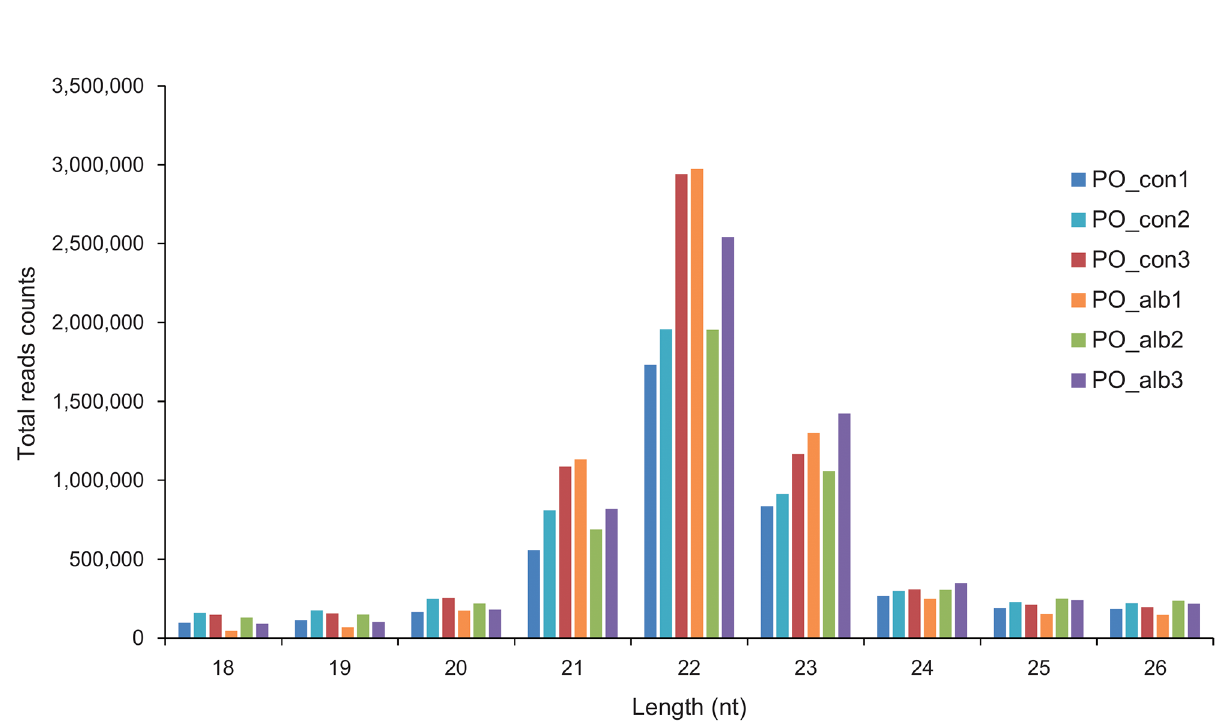
Fig 4. Length distribution of small RNAs. The clean reads of small RNAs were distributedfrom 18 nt to 26 nt in six librariesincluding PO_con1, PO_con2, PO_con3, PO_alb1, PO_alb2, and PO_alb3. The reads of 20–24 nt accountedfor 84–93%of small RNAs.